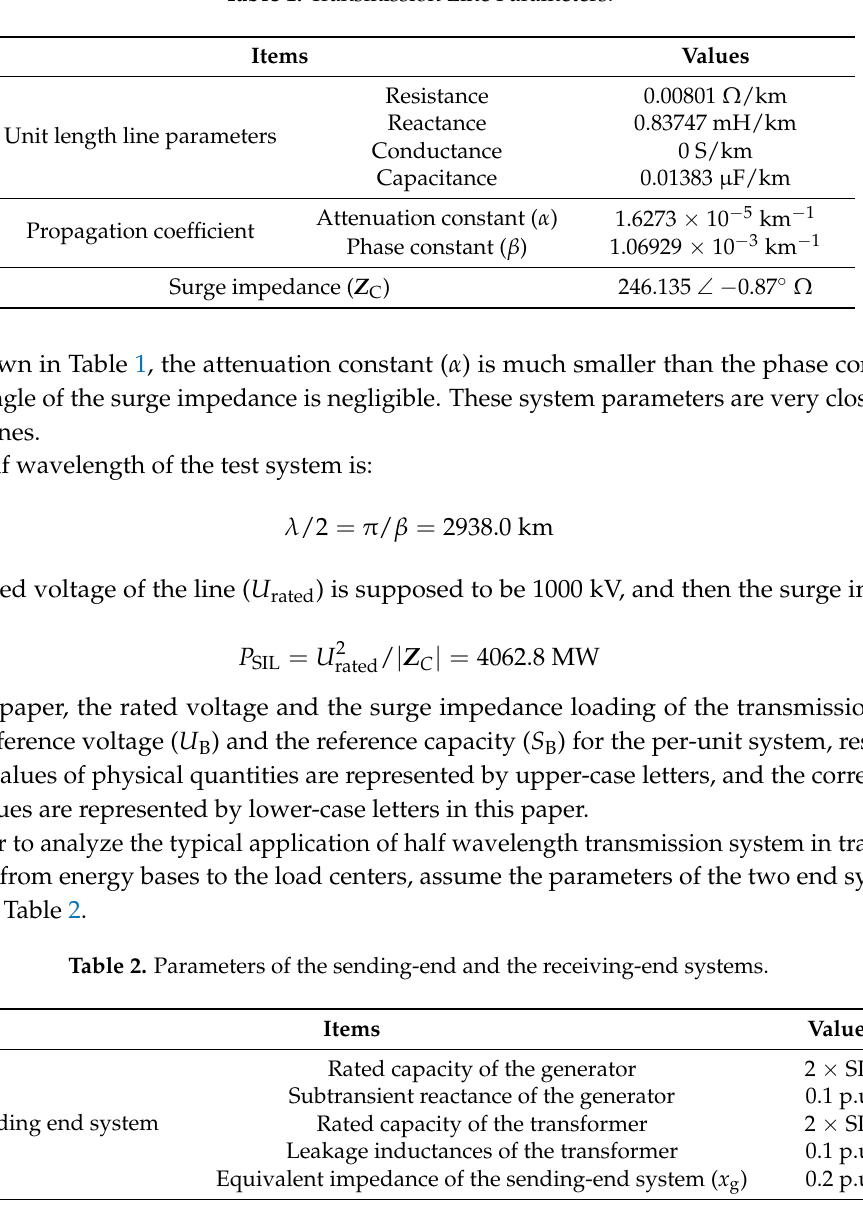
Table 1. Transmission Line Parameters.